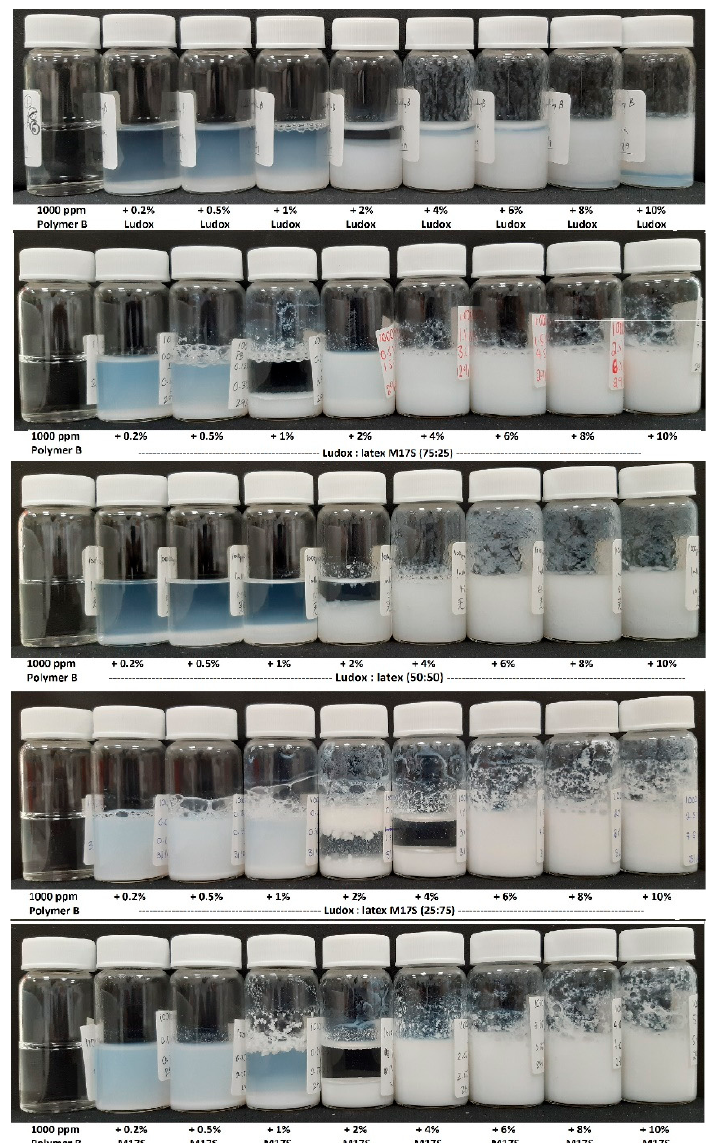
Figure 3. Representative phase behavior of the binary particle/polymer dispersions studied here; mixtures of 1000 ppm HEC LR (labelled “Polymer B”) with Ludox and latex as a function of increasing total particle concentration (0, 0.2, 0.5, 1, 2, 4, 6, 8 and 10% w/v ( left to right ) and particle ratios (Ludox:latex) (100:0, 75:25, 50:50, 25:75 and 0:100 ( top to bottom ).